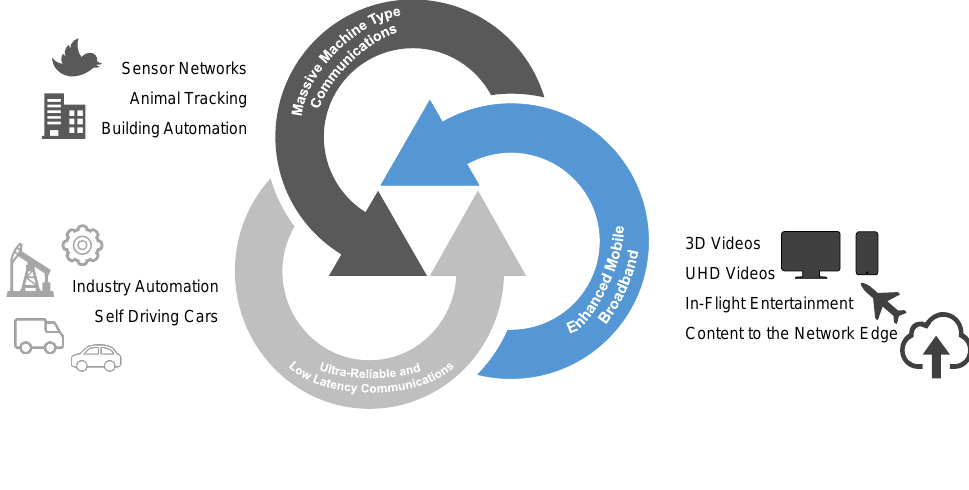
Figure 1. 5G use case